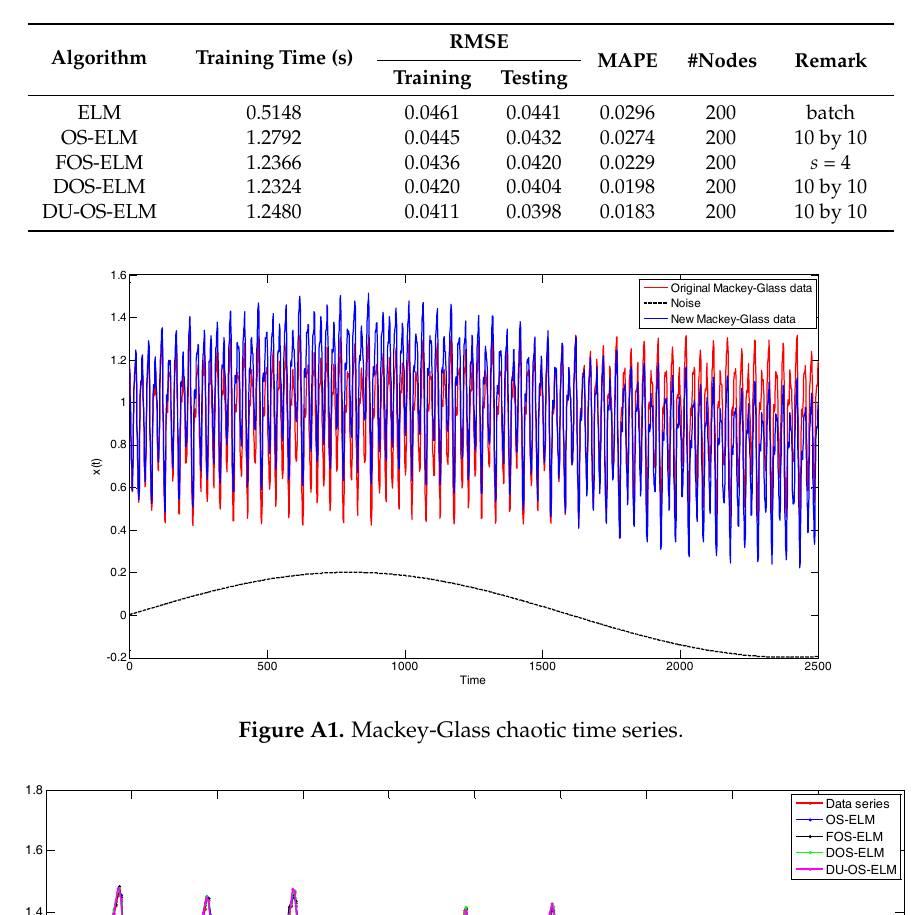
Figure A3. Error results of Mackey-Glass chaotic time series.